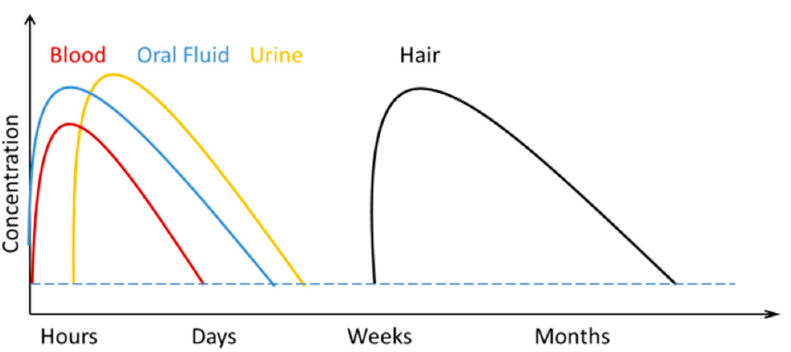
Figure 4. General drug detection window (based on [66]).